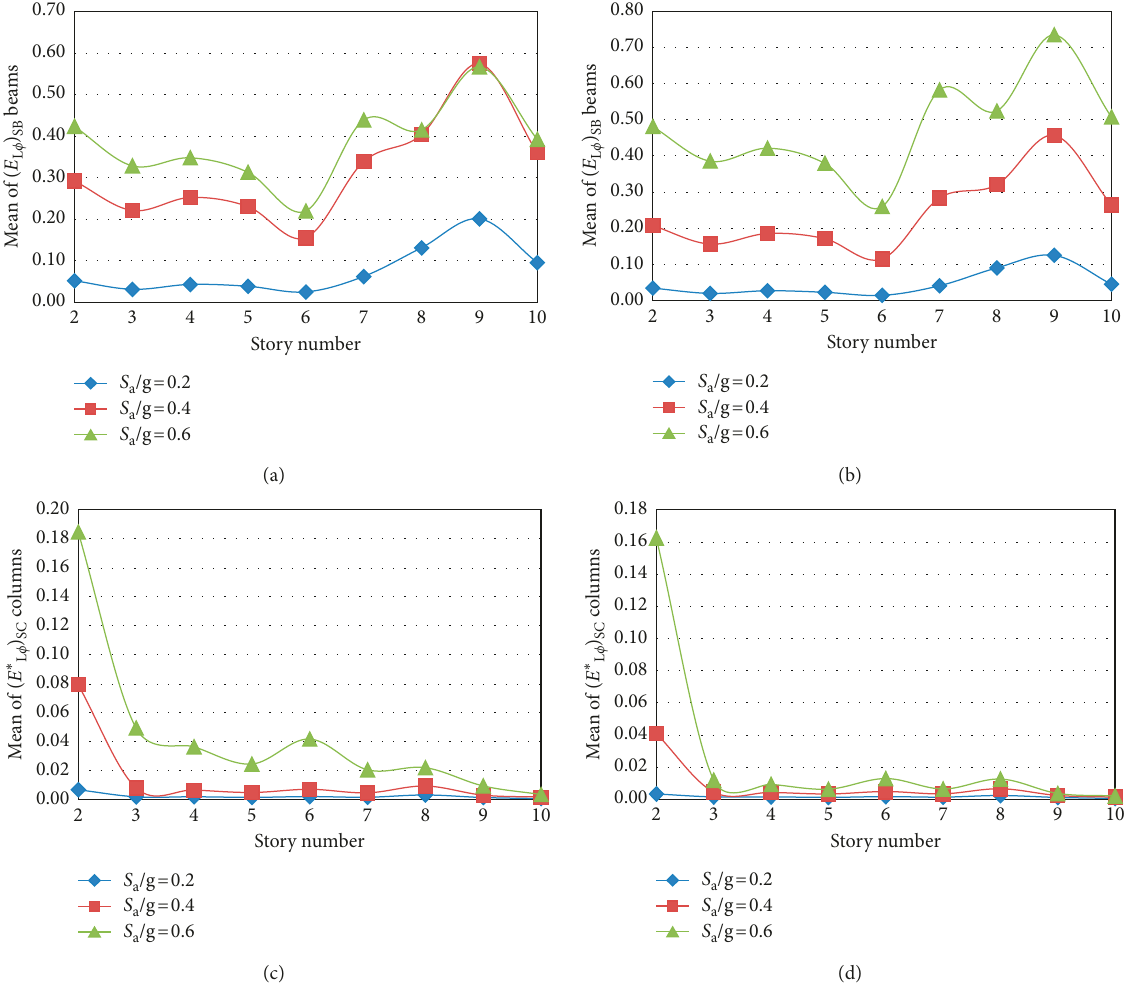
Figure 7: Mean values of local normalized energy demands, 10-level building: (a) beams NS; (b) beams EW; (c) columns NS; (d) columns EW.